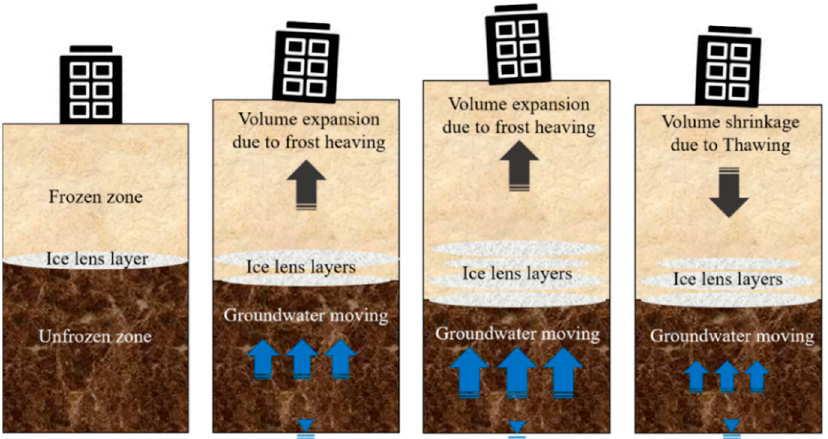
Figure 1. Uneven permafrost thawing underneath a building foundation in Kangerlussuaq. (Re- printed with permission from ref. [17]. (photo by: Thomas Ingeman-Nielsen)).